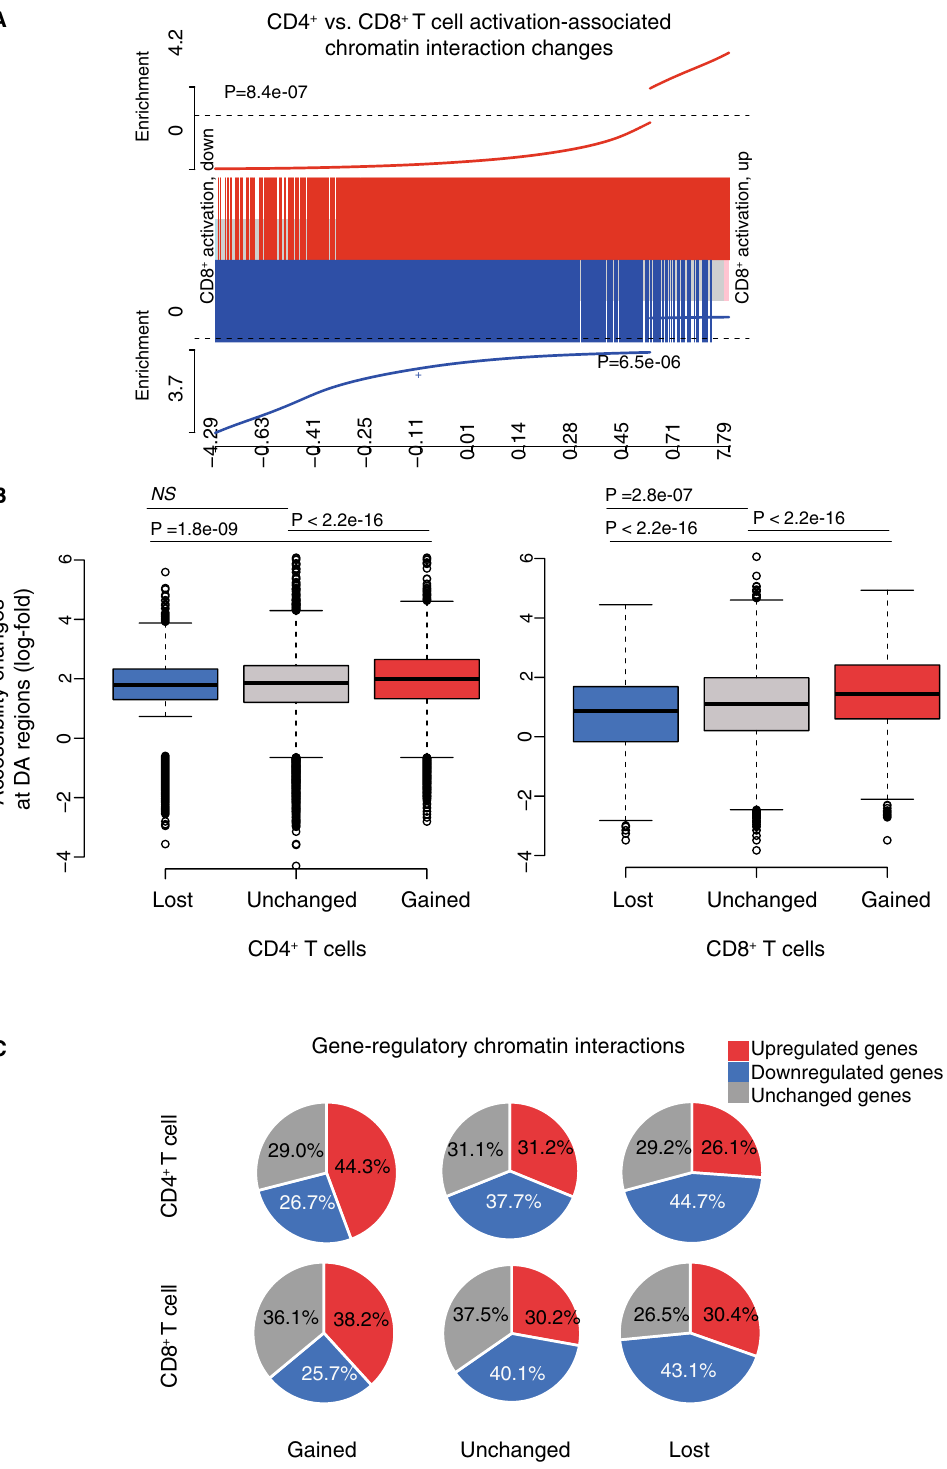
Figure 3. T cell activation induces genome-wide changes in gene-regulatory interactions. ( A ) Barcode enrichment plot showing that activation-associated DIs in CD4 + T cells are similarly ranked in CD8 + T cells. The plot is exactly analogous to Figs. 2C,D but for DI bin-pairs instead of DA peaks or DE genes. ( B ) Box plots showing that the increased accessibility at DA regions in gene-regulatory chromatin interactions ‘gained’ is higher than that at gene-regulatory chromatin interactions ‘unchanged’ or ‘lost’, following CD4 + (left) and CD8 + (right) T cell activation. Shown are the median (central horizontal line), interquartile range (boxes), values of the upper and lower quartiles (whiskers), outliers beyond 1.5 IQR (circles). Statistical comparisons were made with the unpaired Wilcoxon test. ( C ) Pie chart showing distribution of down-regulated, up-regulated or unchanged target genes linked to ‘lost’ (top) or ‘gained’ (bottom) of regulatory